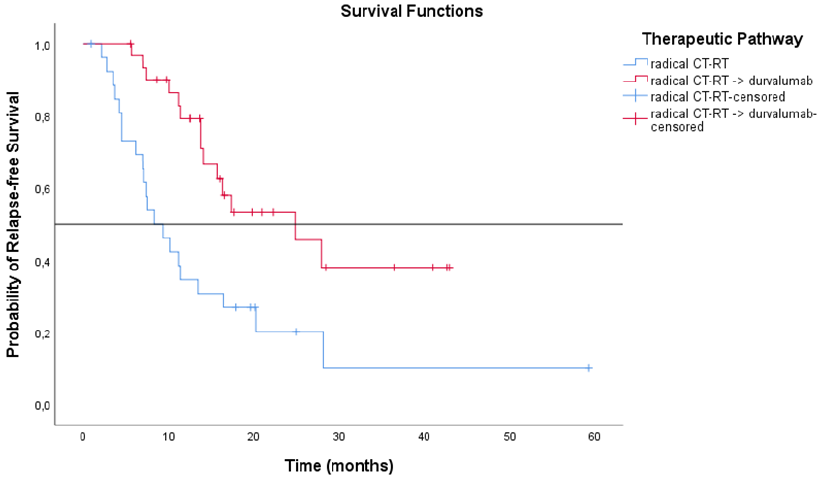
Figure 18. Kaplan–Meier curves of estimated relapse-free survival in patients treated after 2018 who underwent definitive chemo-radiation therapy according to treatment pathway. CT-RT, chemo-radiation therapy.